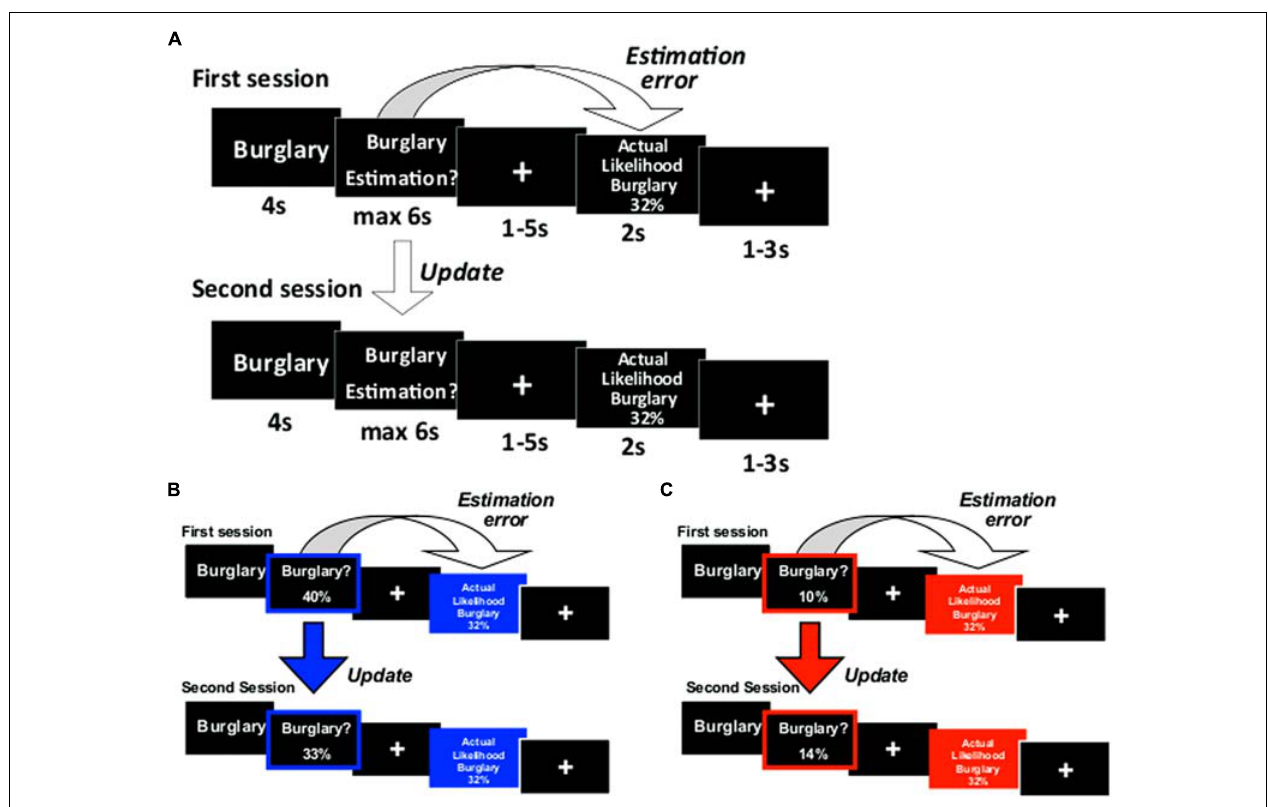
estimations. Examples of trials for which the participant’s estimate was (B) higher or (C) lower than the average probability. Here, for illustration purposes only, the blue and red frames denote the participant’s response (either an overestimation or underestimation, respectively) and the blue and red filled boxes denote information that calls for an adjustment in a (B) desirable (good news) or (C) undesirable (bad news)